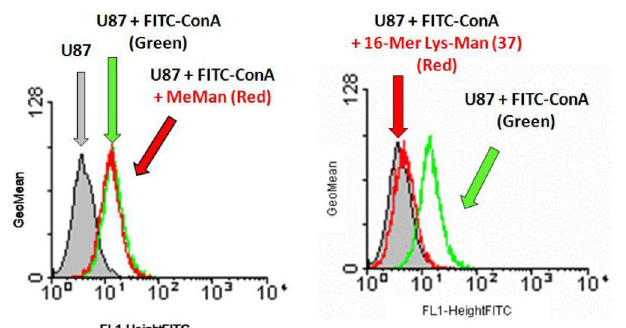
FIGURE 15 – Inhibition of binding of fluorecently-labelled plant lectin ConA to glyoblastomas U87 by mannodendrimer 37